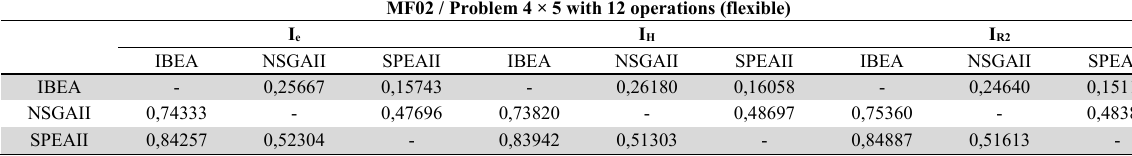
I e , I H , and I R2 (MF02) for IBEA, NSGAII and SPEAII